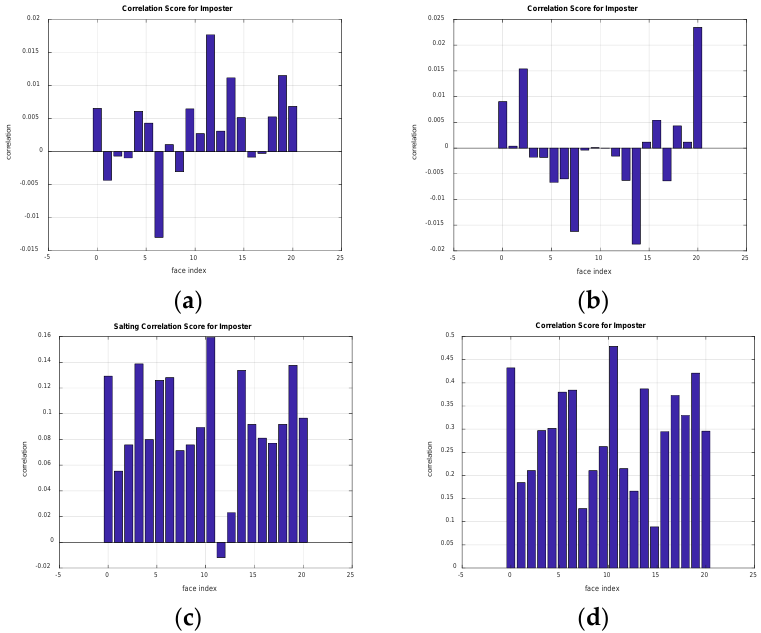
Figure 25. Correlation scores for unauthorised imposter patterns (for LFW dataset) for ( a ) CFR1, ( b ) CFR2, ( c ) homomorphic transform followed by salting and ( d ) homomorphic transform followed by random kernel convolution.